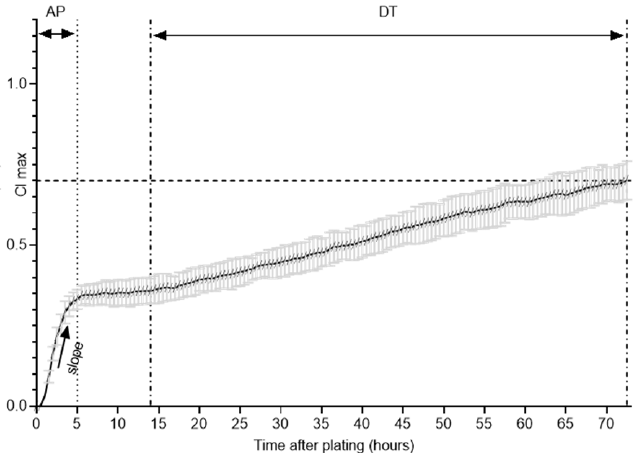
Figure 2. Schematic presentation of xCELLigence system experiment. The growth curves were analyzed within 72 h for slope during the adhesion period (AP), cell index (CI max), and doubling time (DT) during the logarithmic growth phase.